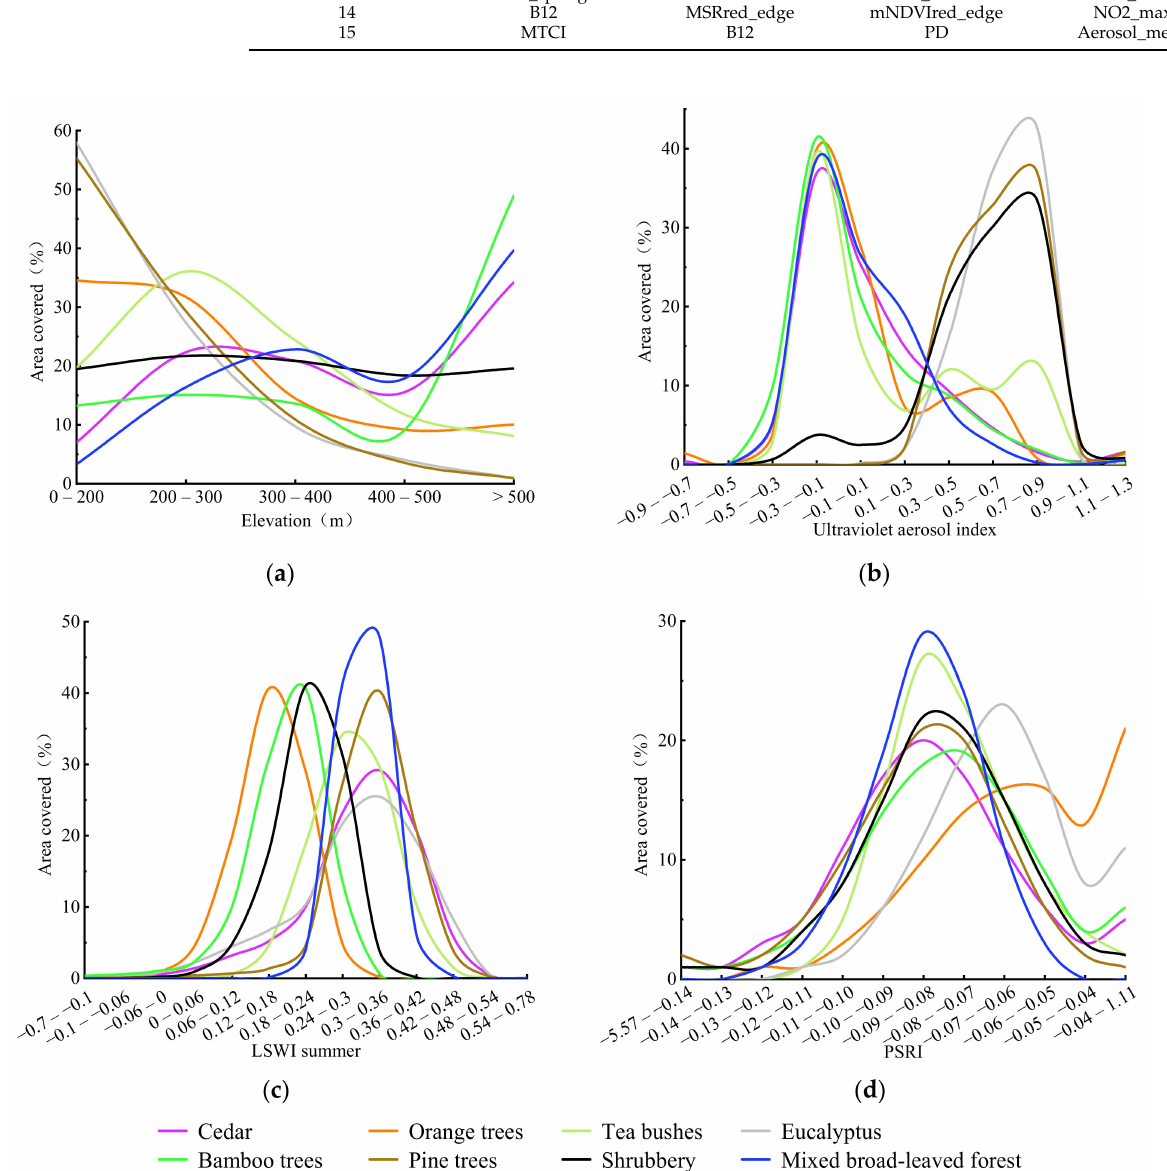
Figure 5. Distribution characteristics of four feature variables with different tree species: ( a ) Elevation feature distribution; ( b ) ultraviolet aerosol feature distribution; ( c ) LSWI_summer feature distribution; ( d ) PSRI feature